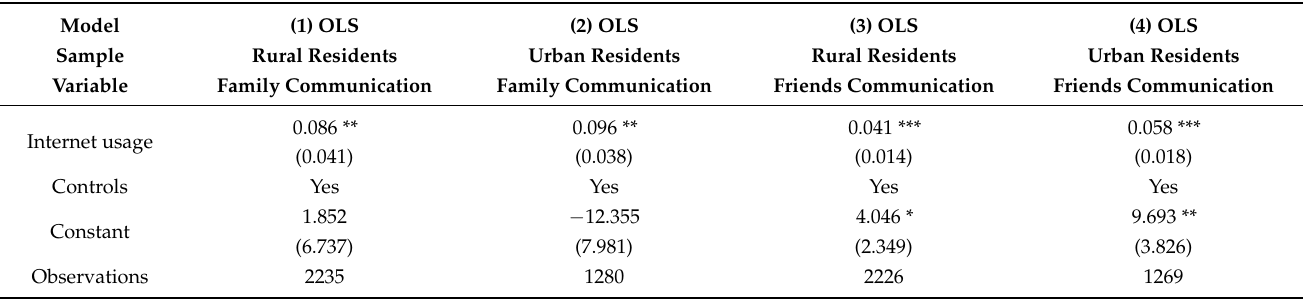
Table 14. Heterogeneity analysis in terms of